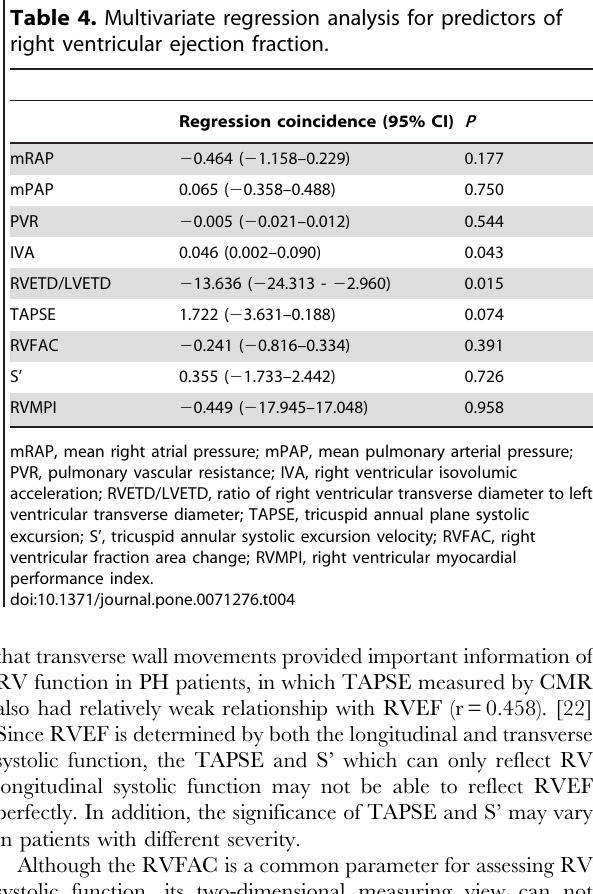
Table 4. Multivariate regression analysis for predictors of right ventricular ejection fraction.